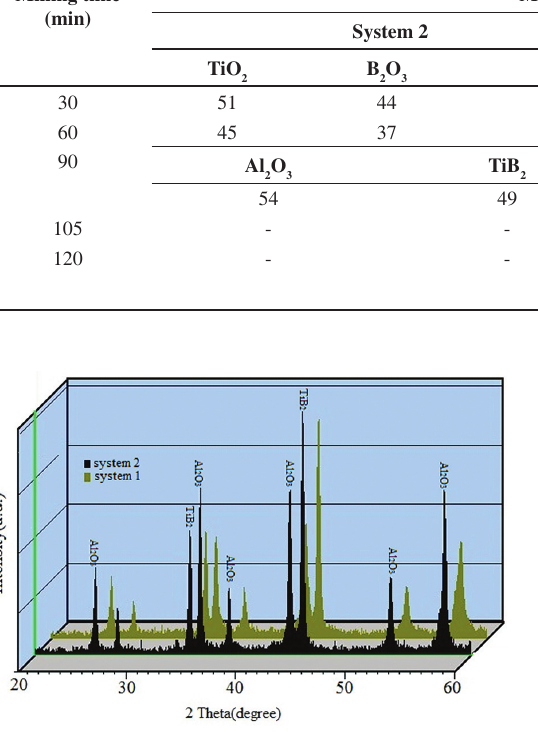
Figure 12. XRD patterns of Al, B Table 5. Mean grain size of both systems in various milling times. Milling time (min)